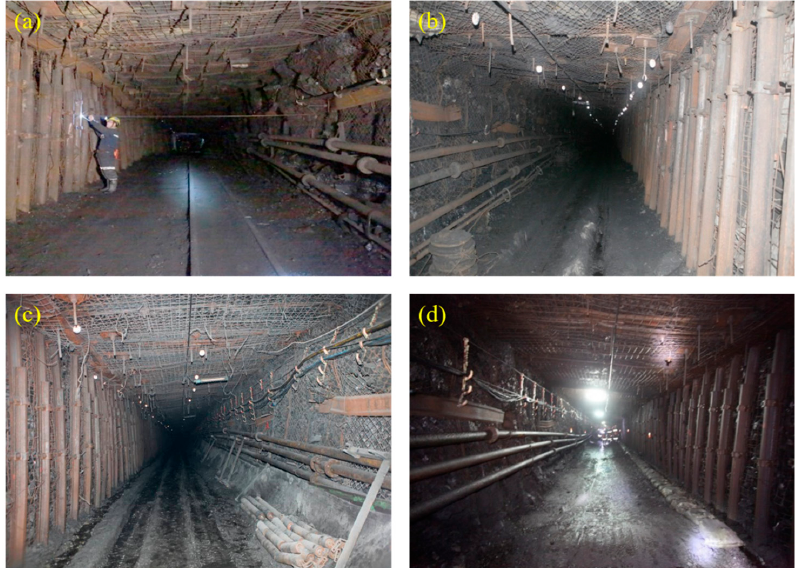
Figure 19. Effects of the surrounding rock control in the Dianping coal mine. ( a ) 100 m from open-off cut; ( b ) 200 m from open-off cut; ( c ) 300 m from open-off cut; ( d ) 400 m from open-off